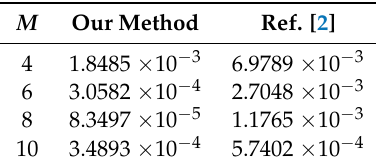
Table 6. Comparison of the maximum absolute errors (MAEs) of Problem 4 with [2] for α = 1.3 and different values of M